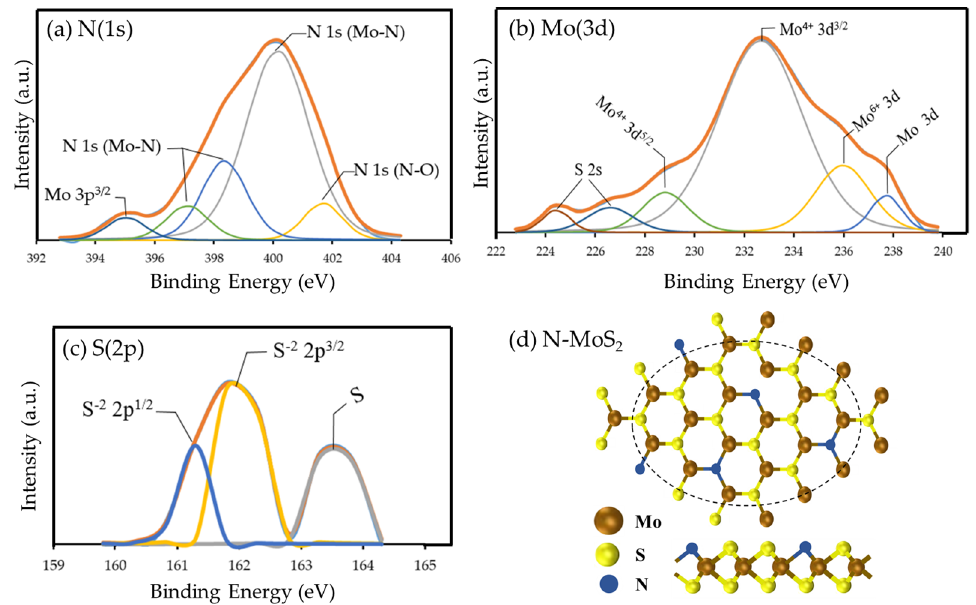
Figure 5. XPS spectra demonstrating energies of core binding. ( a ) N (1s) ( b ) Mo (3d), and ( c ) S (2p) of XPS spectra taken by N-MoS 2 QDs created by PLA in LN 2 . The calibrated peak for all spectra is the C 1s peak, which is placed at 284.8 eV. The N (1s), Mo (3d), and S (2p) peaks are deconvoluted to identify the corresponding bonding states and chemical species following Shirley background subtraction alongside 80% Gaussian-20% Lorentzian fitting. Thus, the evidence of N-doping is obviously validated. ( d ) Typical scheme of top and side views of the covalent N-MoS 2 QDs, for instance, the formation of molybdenum nitride (MoN) and dimolybdenum nitride (Mo 2 N) by PLA in LN 2 . Note that, XPS attests the nitrogen doping lucidly takes place during process.